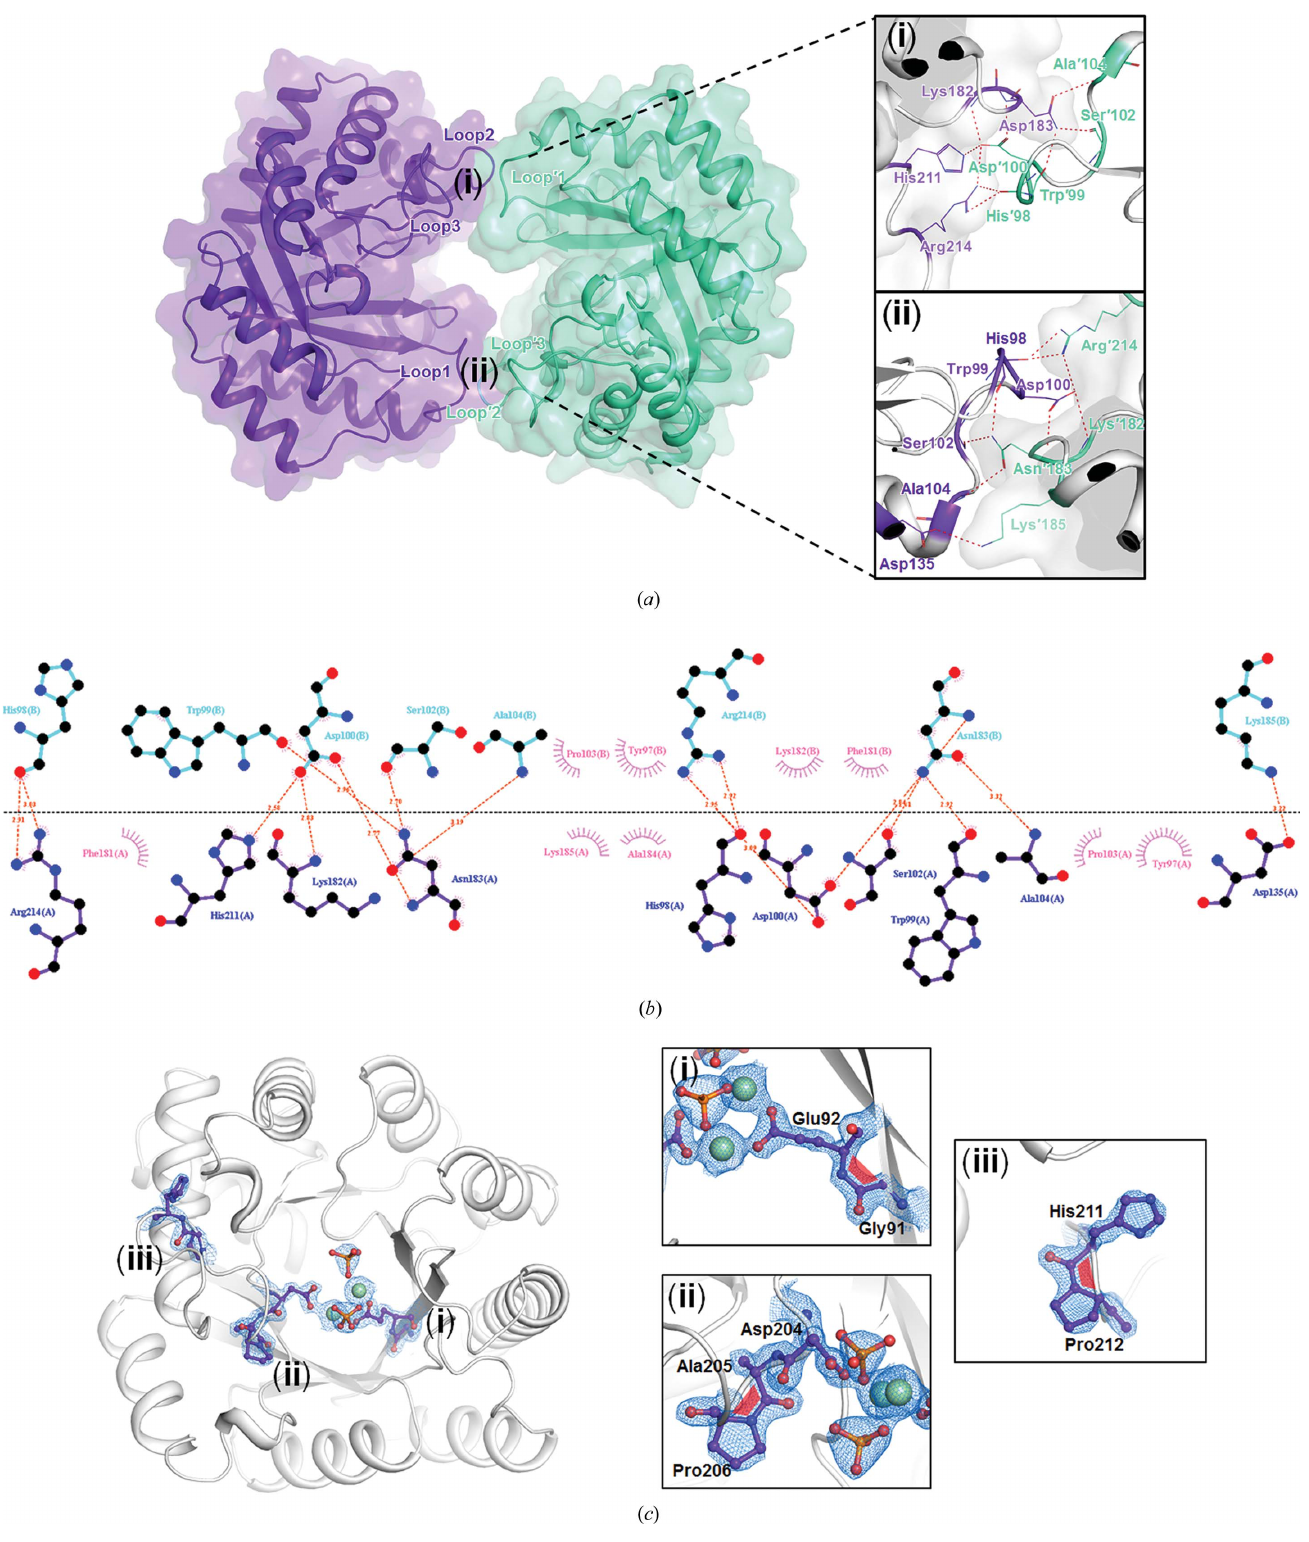
Figure 2 Distinct features of the Sa TatD structure. ( a ) Chains A and B are shown as ribbon diagrams within the transparent surface colored purple and cyan, respectively. The dimeric interface areas consisting of Loop 0 1–Loop2–Loop3 (i) and Loop1–Loop 0 2–Loop 0 3 (ii) are expanded in the right panel. The residues contributing to hydrogen-bonding interactions are labeled and shown as lines. The interactions are presented as dotted lines (red). ( b ) LigPlot diagram presenting hydrophilic (red dotted lines) and hydrophobic (pink spoked curves) interactions in the dimeric interface. ( c ) The cis -peptide bonds observed in the Sa TatD structure. Each cis -peptide is enlarged in the right panel (i, ii and iii) and shown as a red trapezoid. The related residues are shown in ball-and-stick representation with 2 mF o (cid:3) DF c electron-density maps contoured at 2.0 (cid:6) as a blue